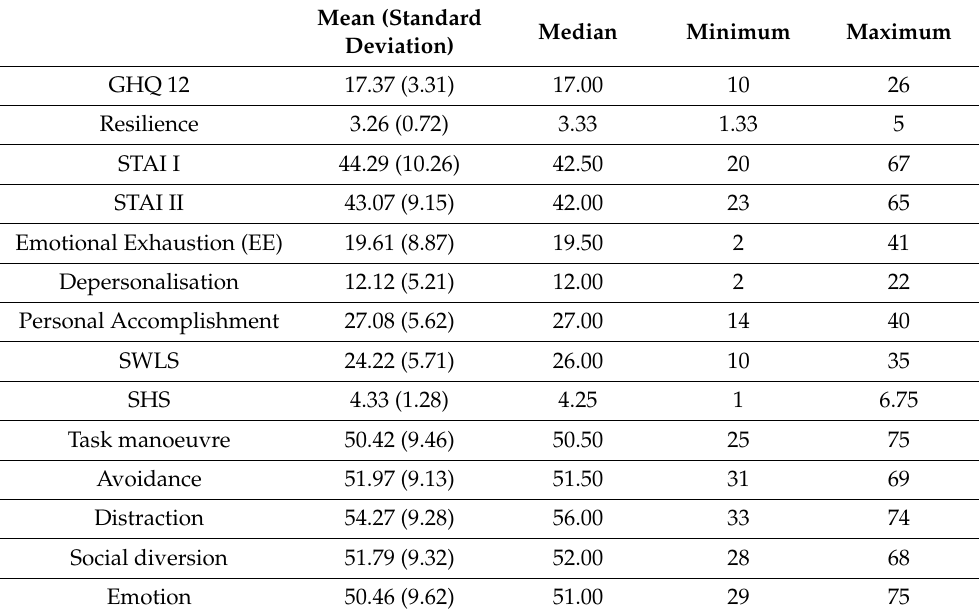
Table 2. Mean standard deviation, percentiles and median, minimum and maximum values of the proposed